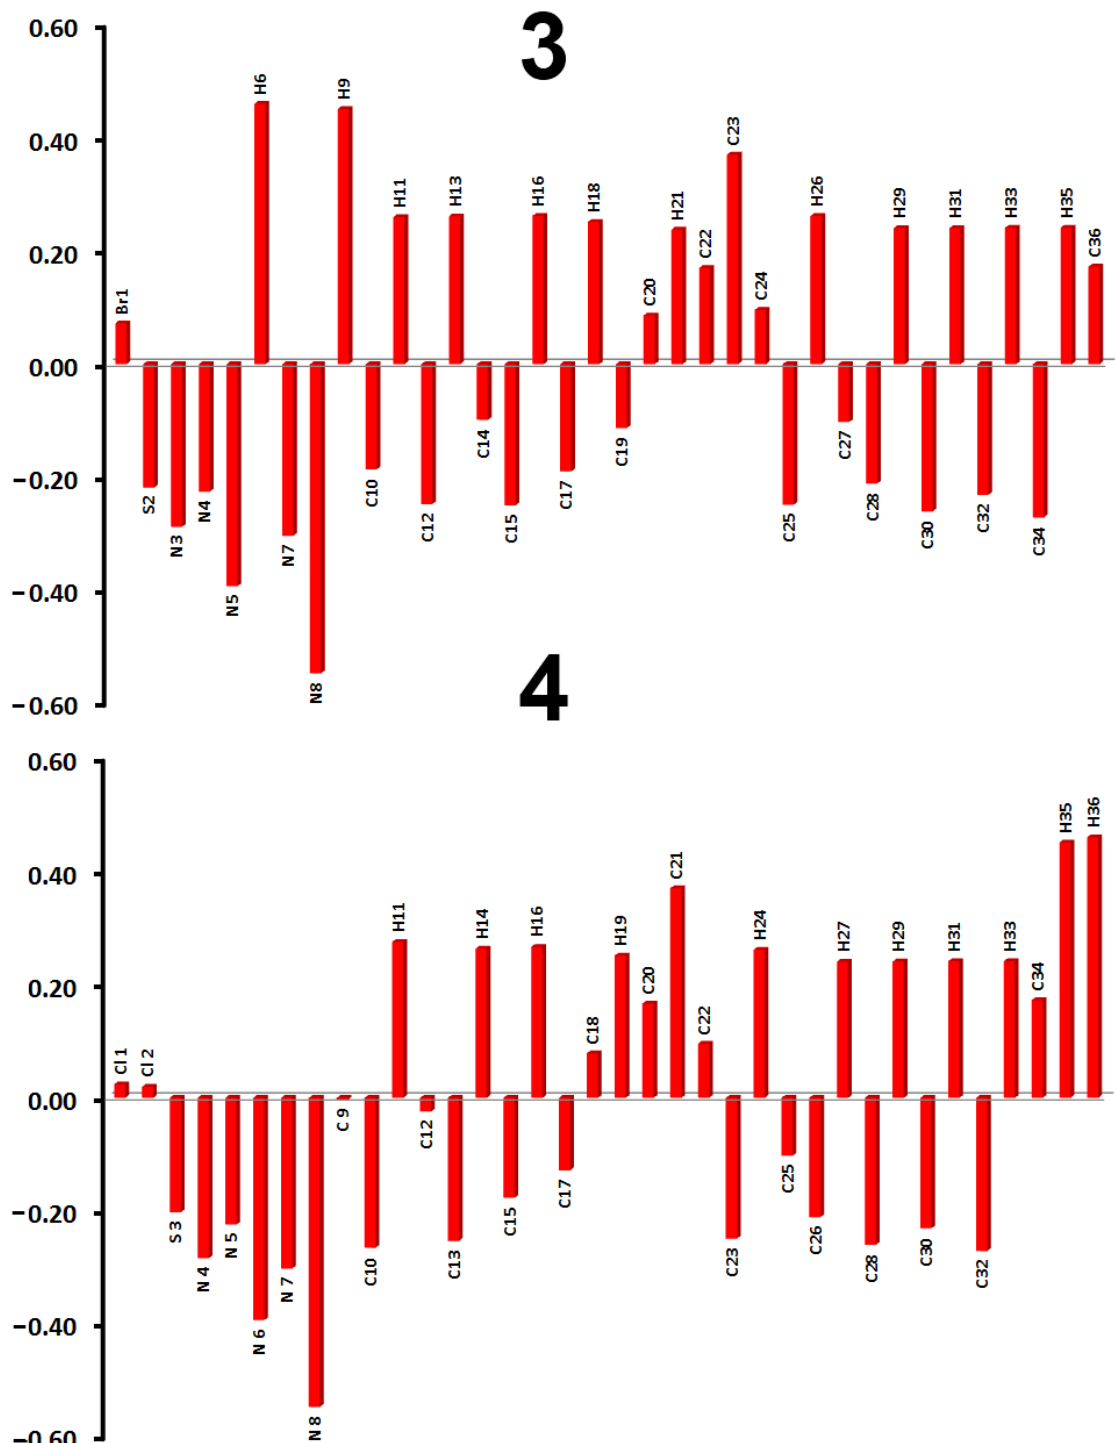
Figure 13. Natural charge population at the different atomic sites for the studied compounds (Table S2; Supplementary data).